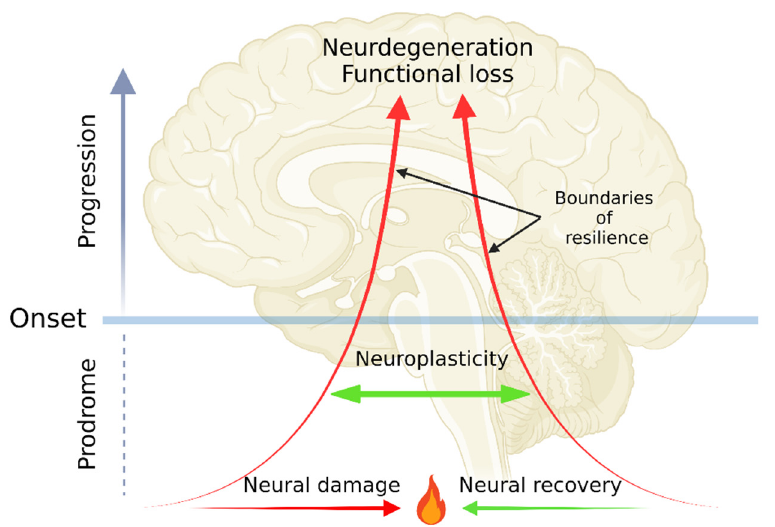
Figure 1. The dynamics of neurodegenerative diseases (NDDs) from prodromal phase, onset, neu- rodegeneration, to functional loss. The pathogenesis of NDDs starts from a tug-of-war between neu- ral damage and neural recovery in prodromal phase. The normal neural functions can be compen- sated by neuroplasticity, which is bounded by functional resilience. Decreasing neuroplasticity and resilience lead to neurodegeneration and functional loss. The figure was created with BioRen-